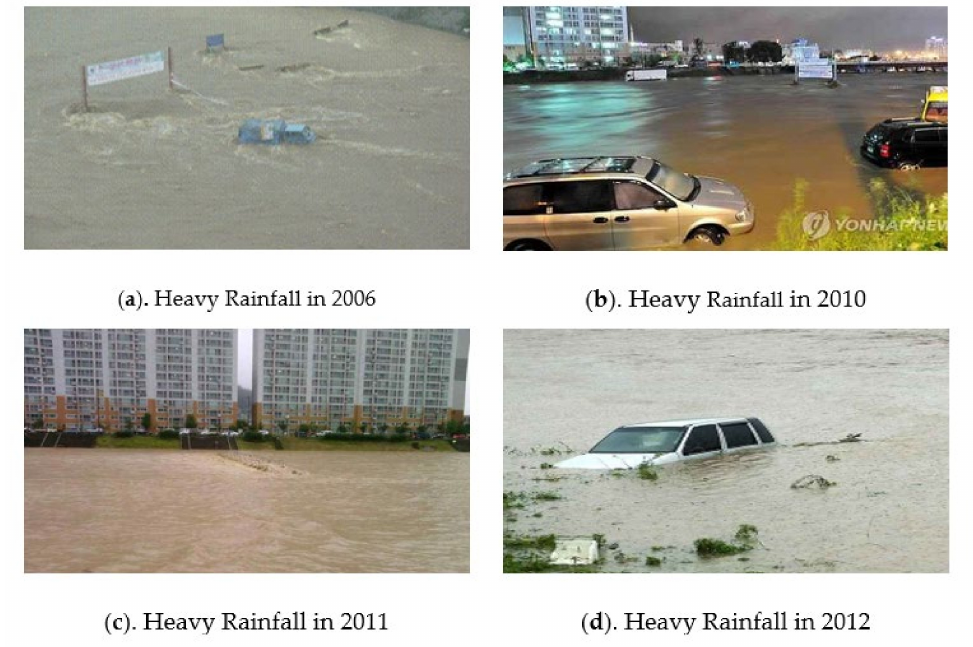
Figure 6. Past Flood Event of Study Basin.